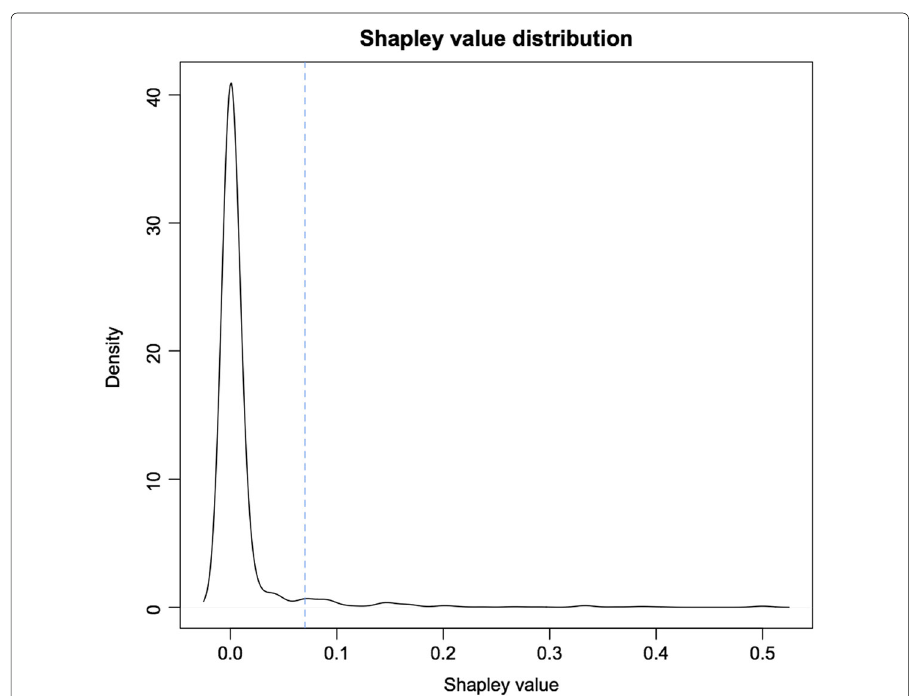
Fig. 6 Second analysis: Shapley value distribution. The density distribution of the index ρ is shown, for k i = 1 for every key-gene i and k i = 0 otherwise. The dotted vertical line represents the cutoff: the 5% of genes with highest index is